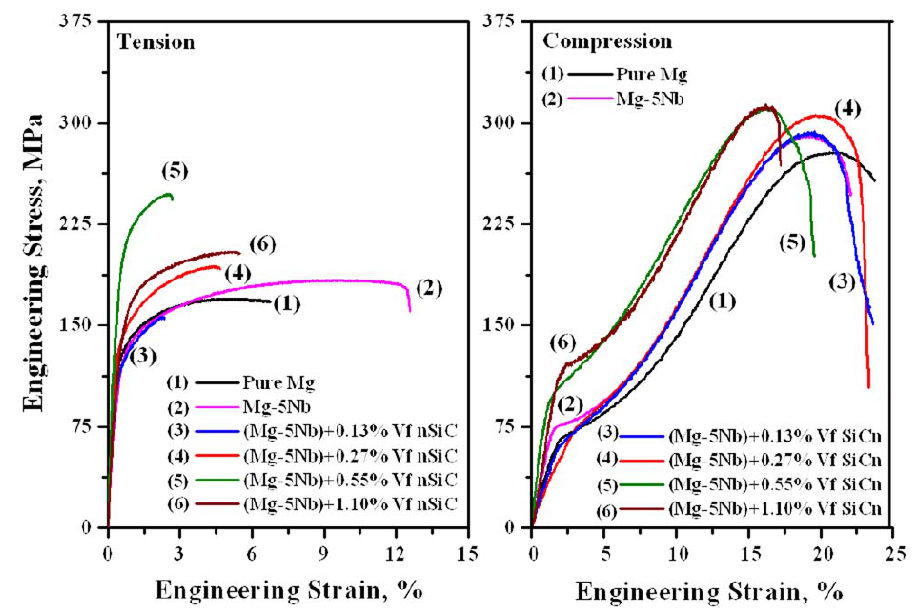
Figure 5. Representative engineering stress-strain curves of pure Mg, Mg-5Nb and Mg-5Nb-SiC composites under tensile and compressive loading n